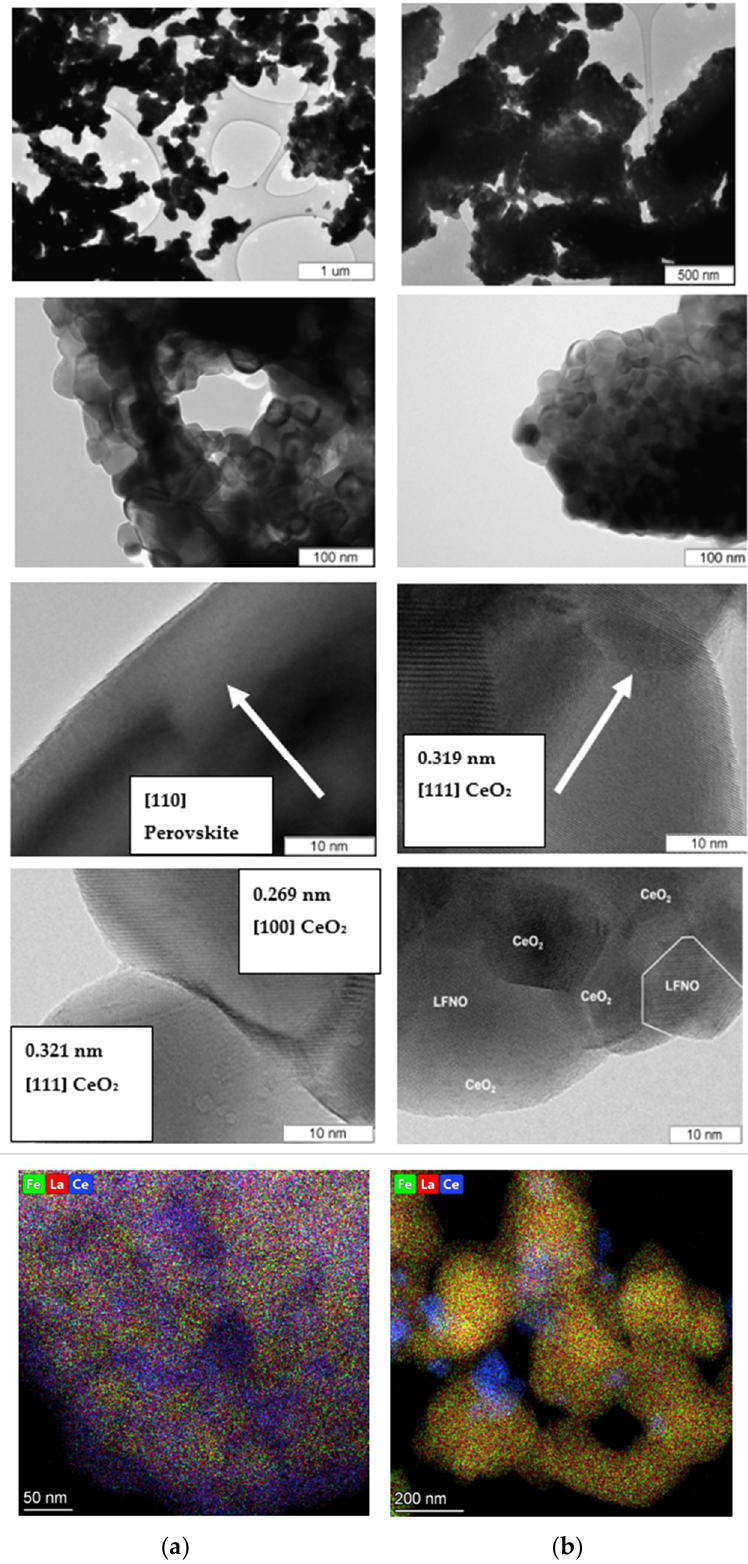
Figure 2. TEM data for LaFe 0.4 Ni 0.6 O 3 /CeO 2 composites 3 ( b ) and 5 ( a ) at different magnifications and EDX mapping for 3 ( b ) and 5 ( a )